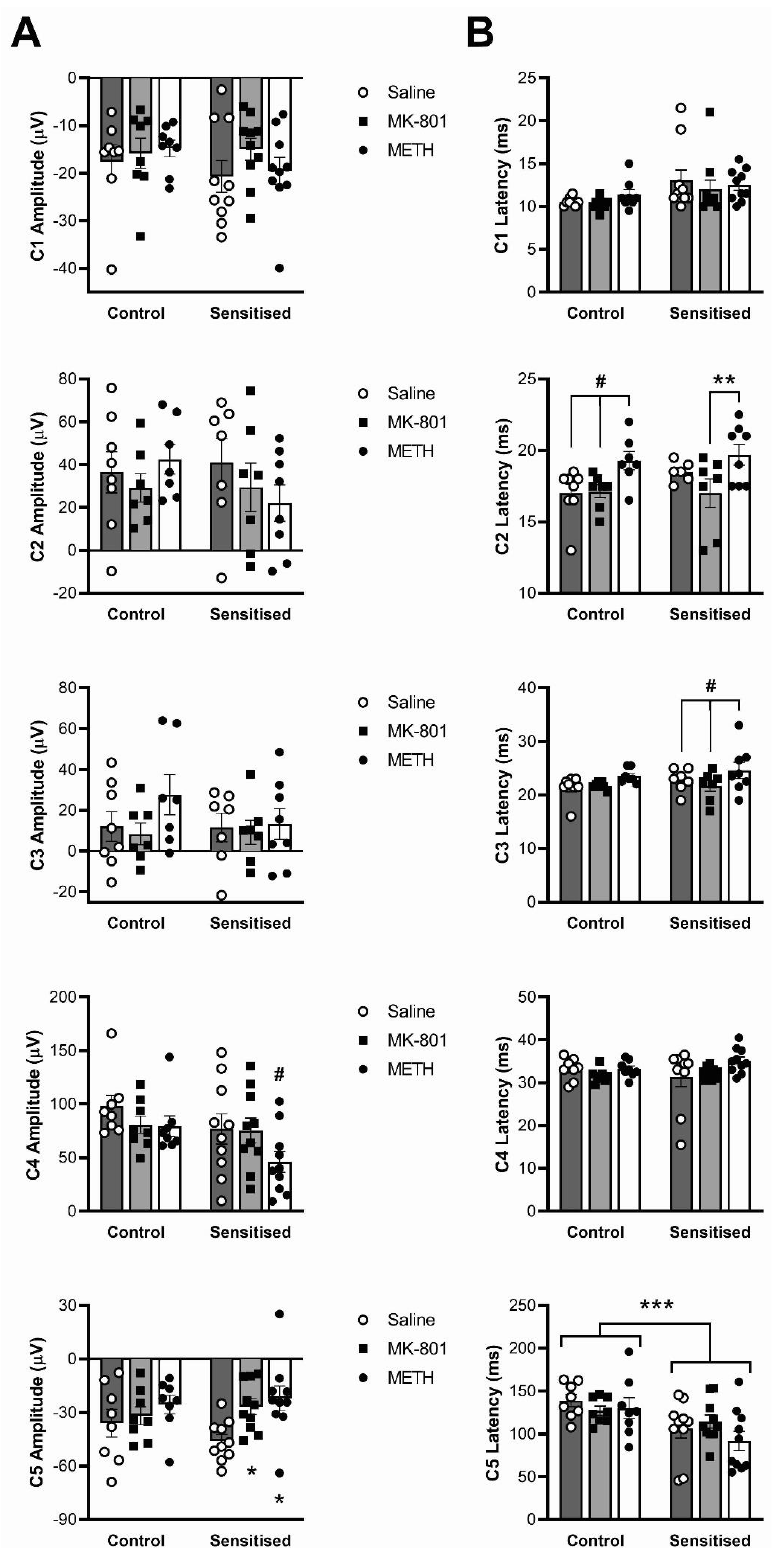
Figure 6. Amplitude ( A ) and latency ( B ) of ERP wave form components (see Figure 2) shown from top to bottom. The mice were chronically treated with either saline vehicle (Control) or METH (Sensitised) and acutely treated with a saline, MK-801 and METH challenge. * p < 0.05 for difference with acute saline treatment; ** p < 0.05 for difference with acute METH treatment; # p < 0.05 for difference with both acute saline and acute MK-801 treatment. *** p < 0.05 for differences between control and sensitised animals. n = 8 control mice; n = 10 sensitised